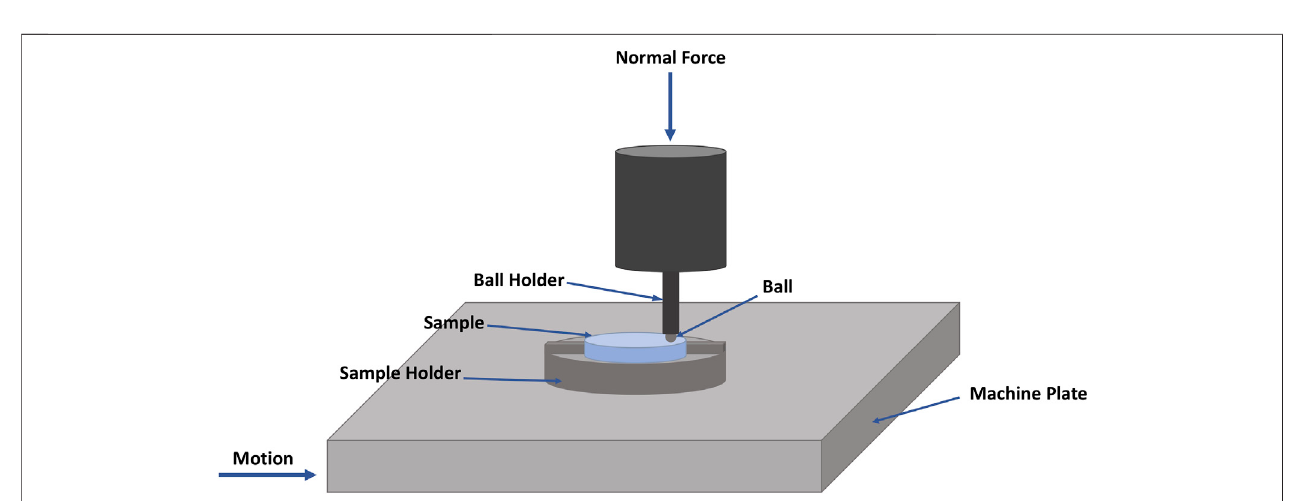
FIGURE 4 | Schematics of the friction characterization